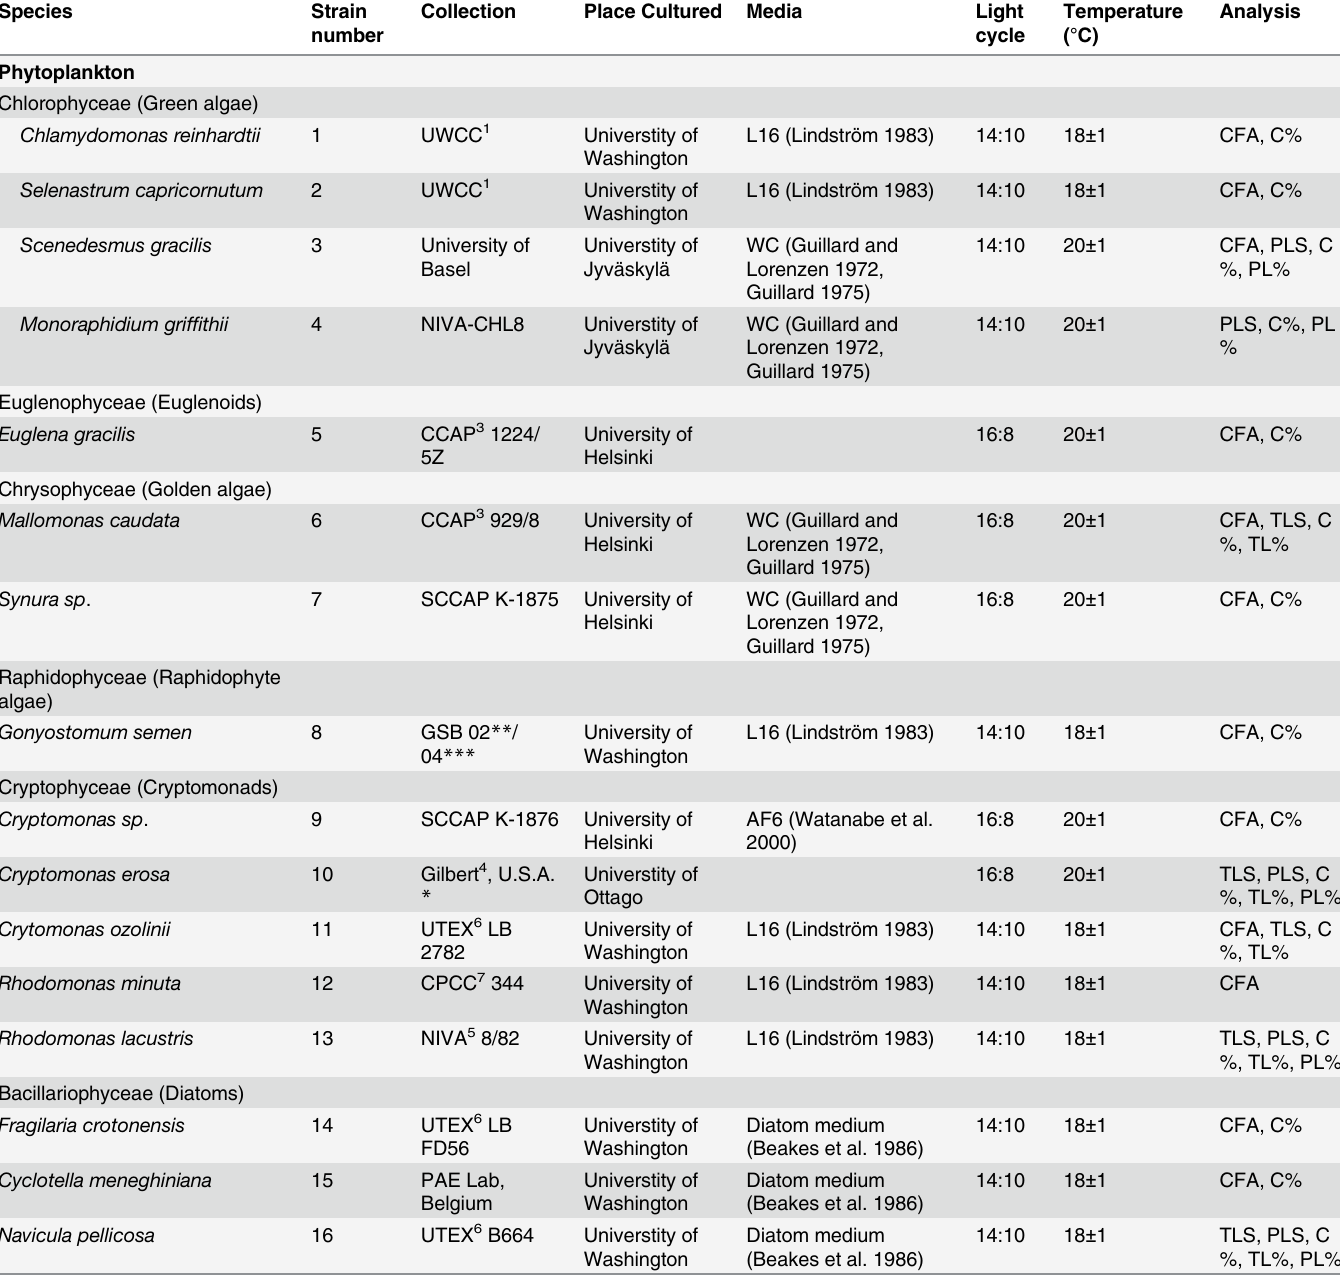
Table 1. Culture conditions used for growth of phytoplankton, and bacteria, and details of terrestrial material analysed. Phytoplankton and bacteria strains used for this study were obtained from different culture collections and universities. They were cultured using optimal media for each strain. Phyto- plankton cultures were maintained under either a 14:10 or 16:8 h light:dark cycle. Temperature of all phytoplankton cultures was 18 − 20°C (average ± SD) and bacteria 23 − 30°C (average ± SD). Terrestrial matter includes finely ground particles of leaves from one grass ( Phragmites ) and two tree ( Betula and Alnus ) taxa. Due to the high number of strains we were not able to perform all analysis from all cultured strains. UWCC: Algal and Fungal Culture Collection of Uni- versity of Washington, Seattle, Washington, USA; Peltomaa: Lammi Biological Station, University of Helsinki, Finland; CCAP: Culture Collection of Algae and Protozoa, Ambleside, Cumbria, UK; Gilbert: Dartmouth College, New Hampshire, USA; NIVA: Norwegian Institute for Water Research, Oslo, Norway; UTEX: University of Texas Culture Collection, University of Texas at Austin, Texas, USA; CPCC: Canadian Phycological Culture Centre, University of Waterloo, Ontario, Canada; CCMP: National Center for Marine Algae and Microbiota, Bigelow Laboratory for Ocean Sciences, Maine, USA; Carolina: Carolina Biologi- cal Supply Company, Burlington, North Carolina, USA. CFA = compound-specific SIA, TLS = lipid stable isotope, PLS = phospholipid stable isotope, C% = carbon content (%), TL% = lipid content (%) and PL% = phospholipid content